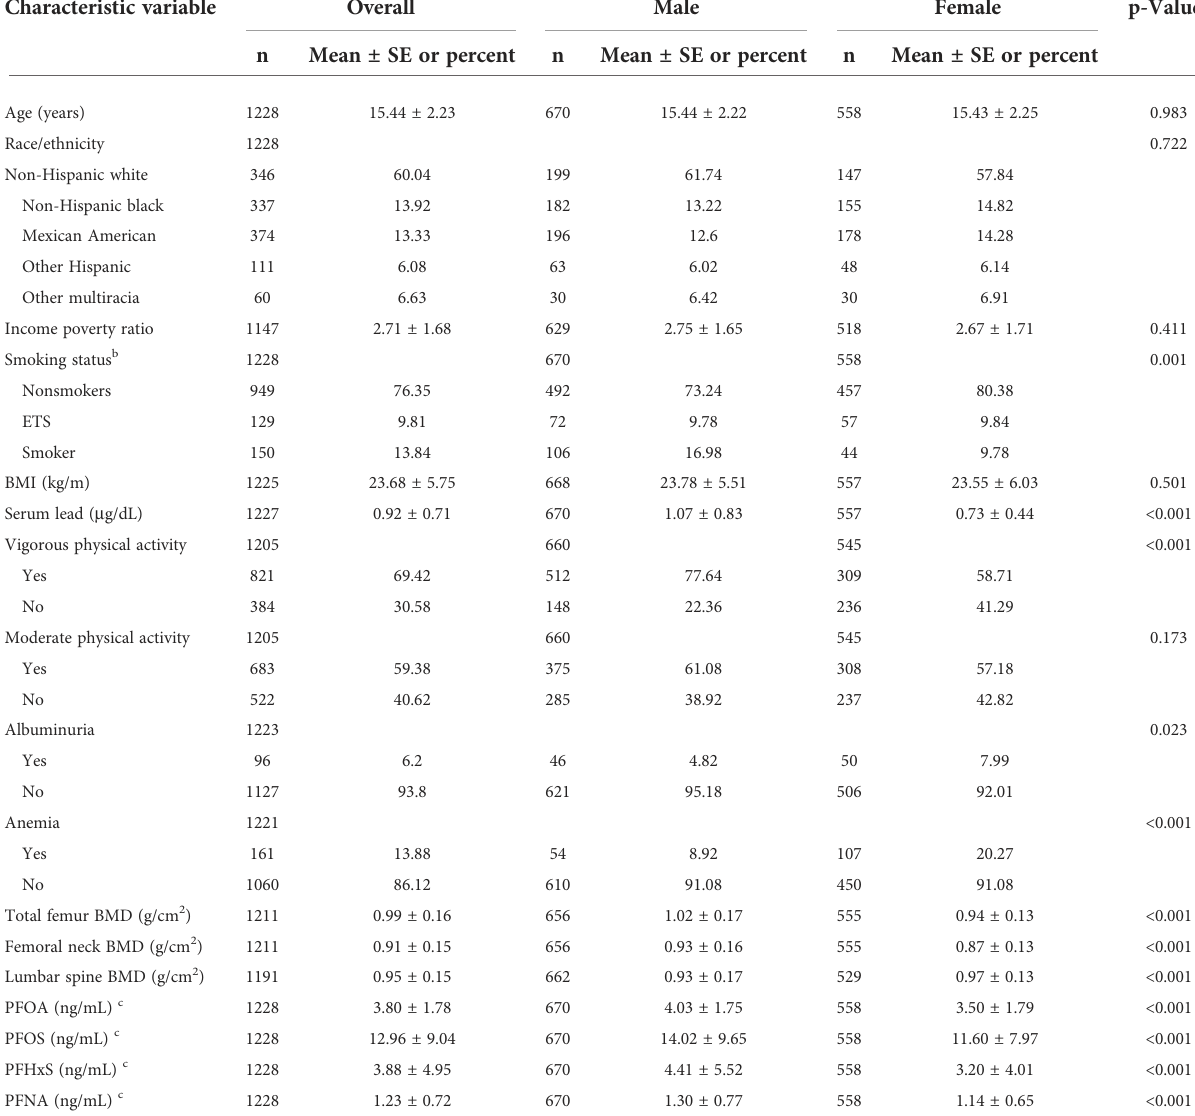
TABLE 1 Characteristics of the study population, overall and by sex, NHANES 2005-2010. Characteristic variable